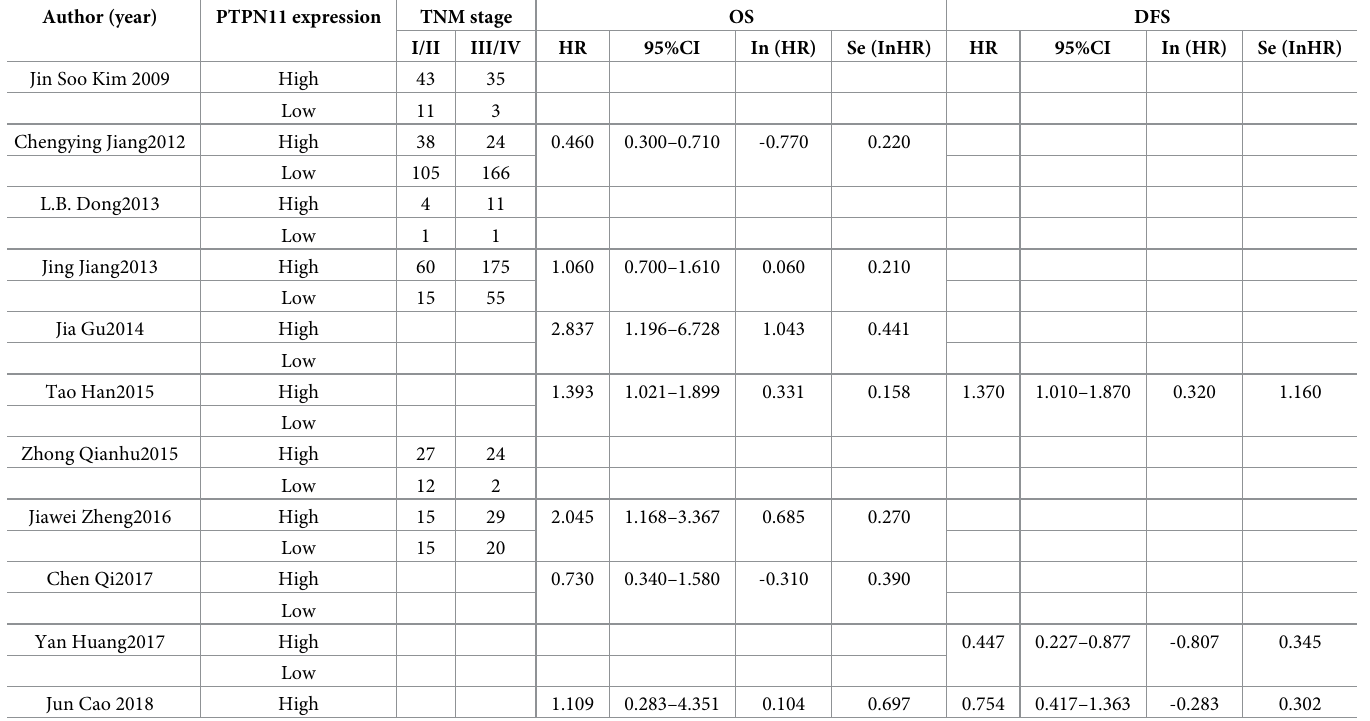
Table 2. The research results of all included studies in the meta-analysis.